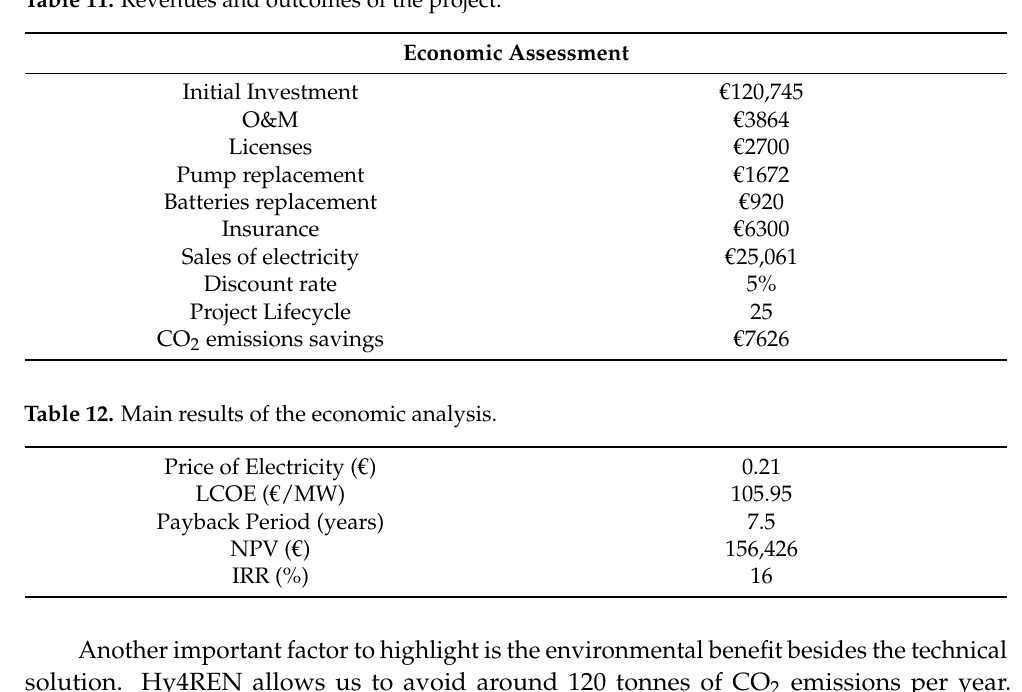
Table 11. Revenues and outcomes of the project.